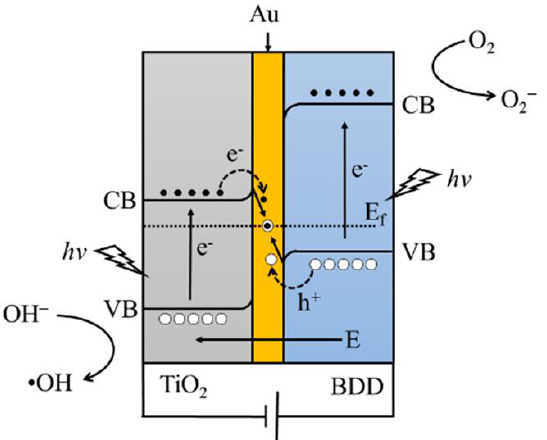
Figure 9. Schematic diagram of the Z-scheme electron transfer in the TiO 2 /Au/BDD electrode.